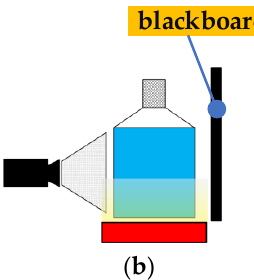
Figure 3. Black and white impurity lighting schemes. ( a ) Black impurity lighting scheme; ( b ) White impurity lighting scheme.